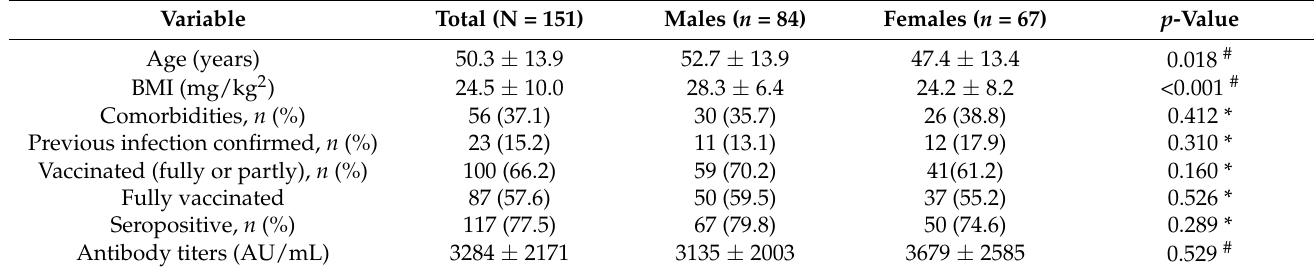
Table 3. Characteristics of the study population in Domokos, stratified by gender (N =